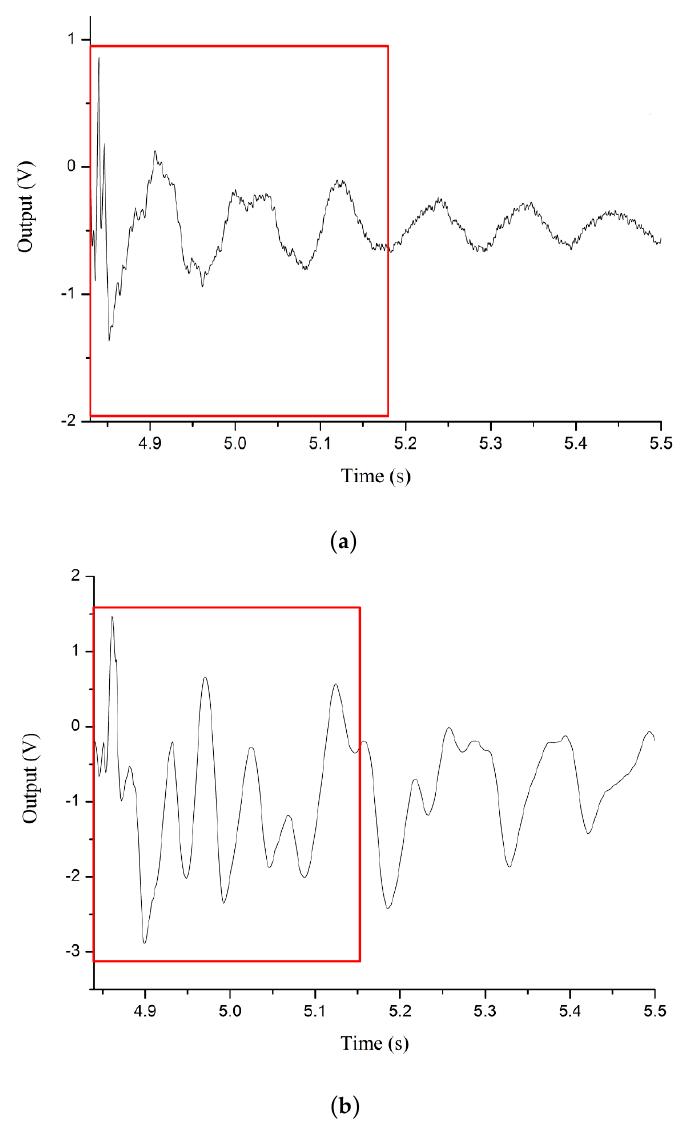
Figure 9. Segments captured from Figure 8 corresponding to the simulation results in Figure 6, and ( a ) is the result of practical experiment for MET with 1.5mm membrane thickness corresponding to the simulation in Figure 6 a ; ( b ) is the result of practical experiment for MET with 1.0mm membrane thickness corresponding to the simulation in Figure 6 b .